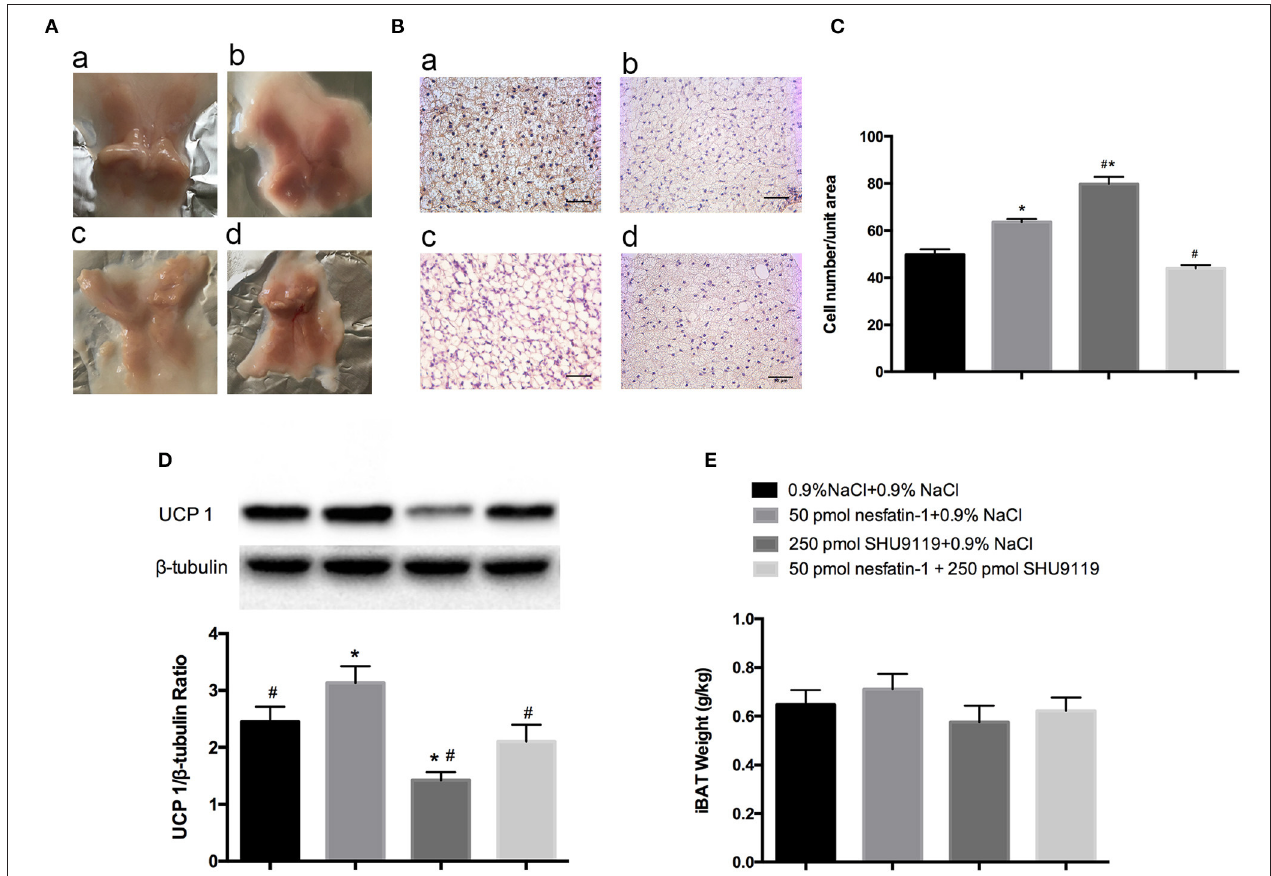
FIGURE 5 | BAT morphology and UCP1 protein analysis after 10 days of injections into the LPBN. Fresh interscapular BAT gross samples (A) and hematoxylin and eosin staining (200 × ) (B) after 10 days of microinjections into the LPBN; (a) 0.9% NaCl group, (b) 50 pmol nesfatin-1 group, (c) 250 pmol SHU9119 group, (d) 50 pmol nesfaint-1 + 250 pmol SHU9119 group. (C) Numbers of cell from the same unit areas were counted and recorded. UCP1 protein expression levels in (D) and weights of (E) BAT were measured. Data represent the mean ± SEM of 7–12 rats/group. * P < 0.05 vs. saline vehicle-injected controls; # P < 0.05 vs. nesfatin-1